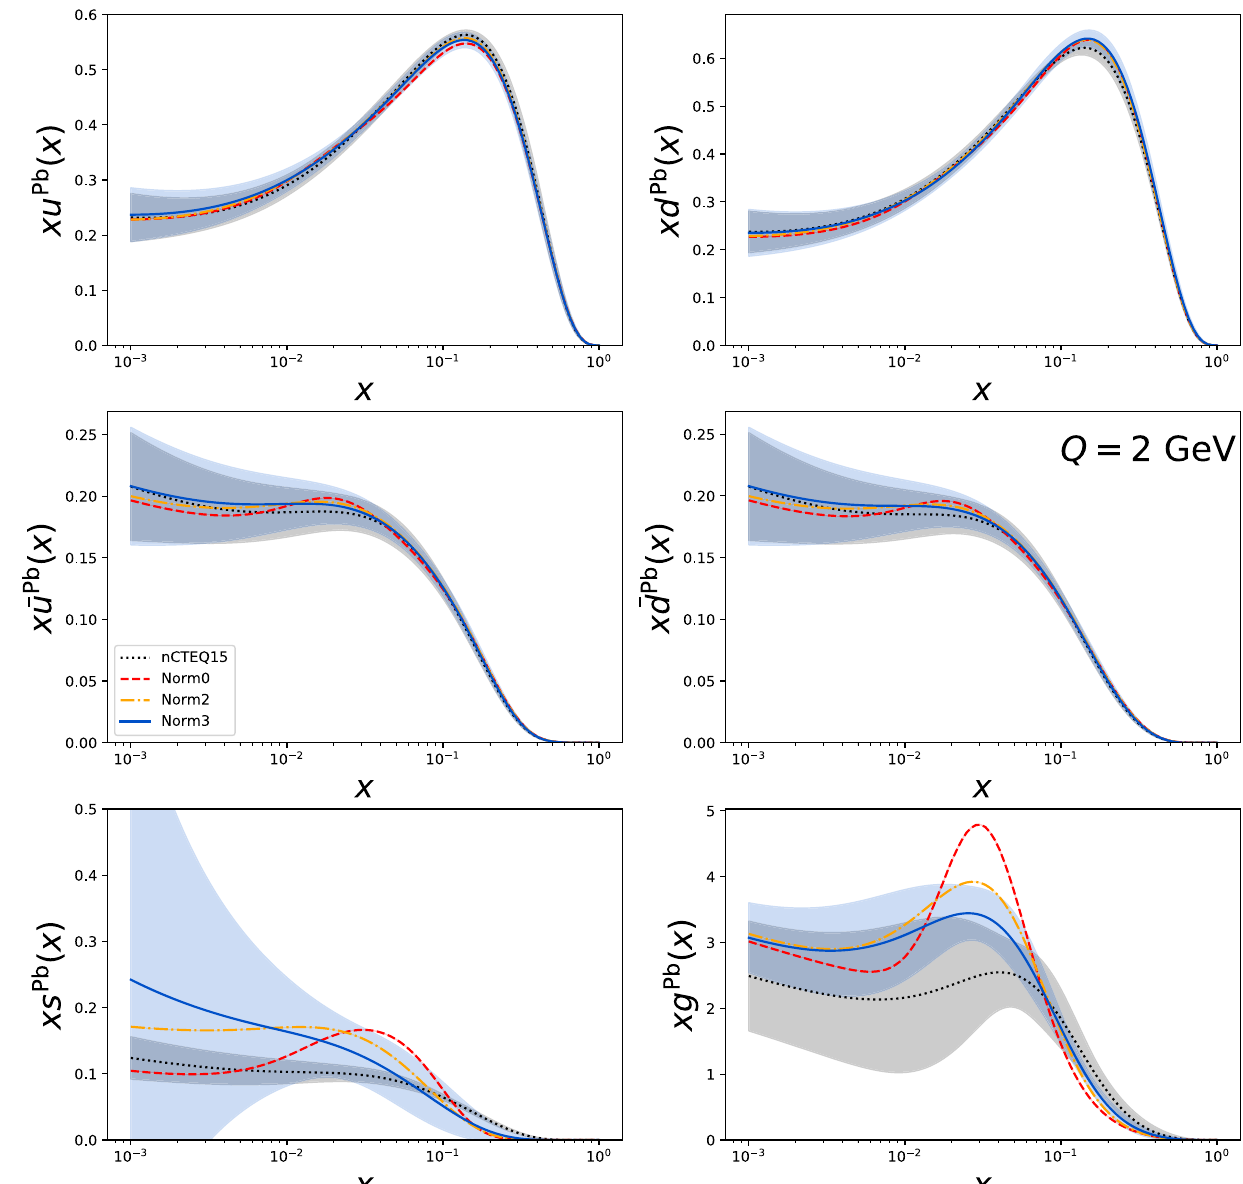
Fig. 7 The full lead (Pb) PDFs for Q = 2GeV. The uncertainty band for nCTEQ15 is shown in gray, and for Norm3 in blue. The increase of